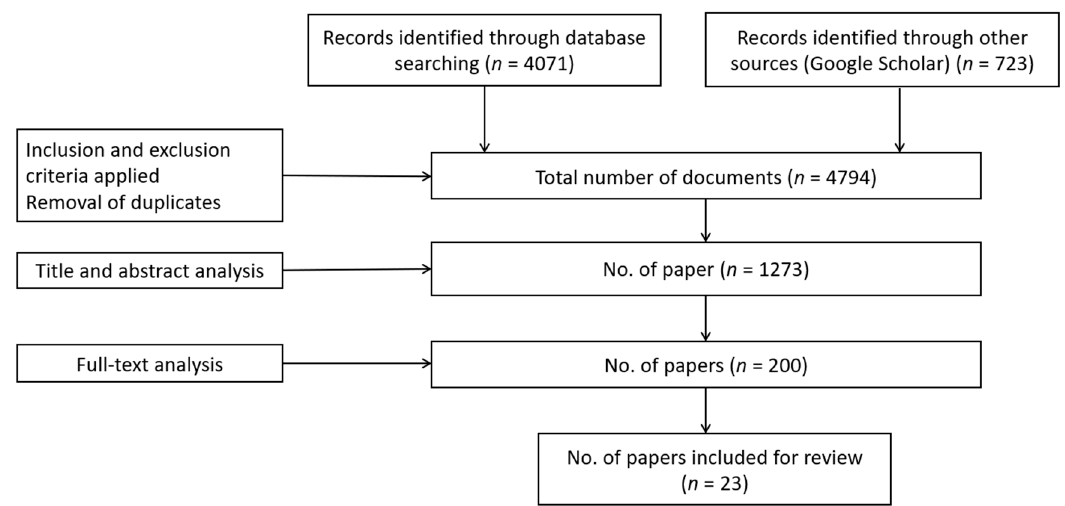
Figure 1. PRISMA flowchart of selected articles (prepared by the authors).